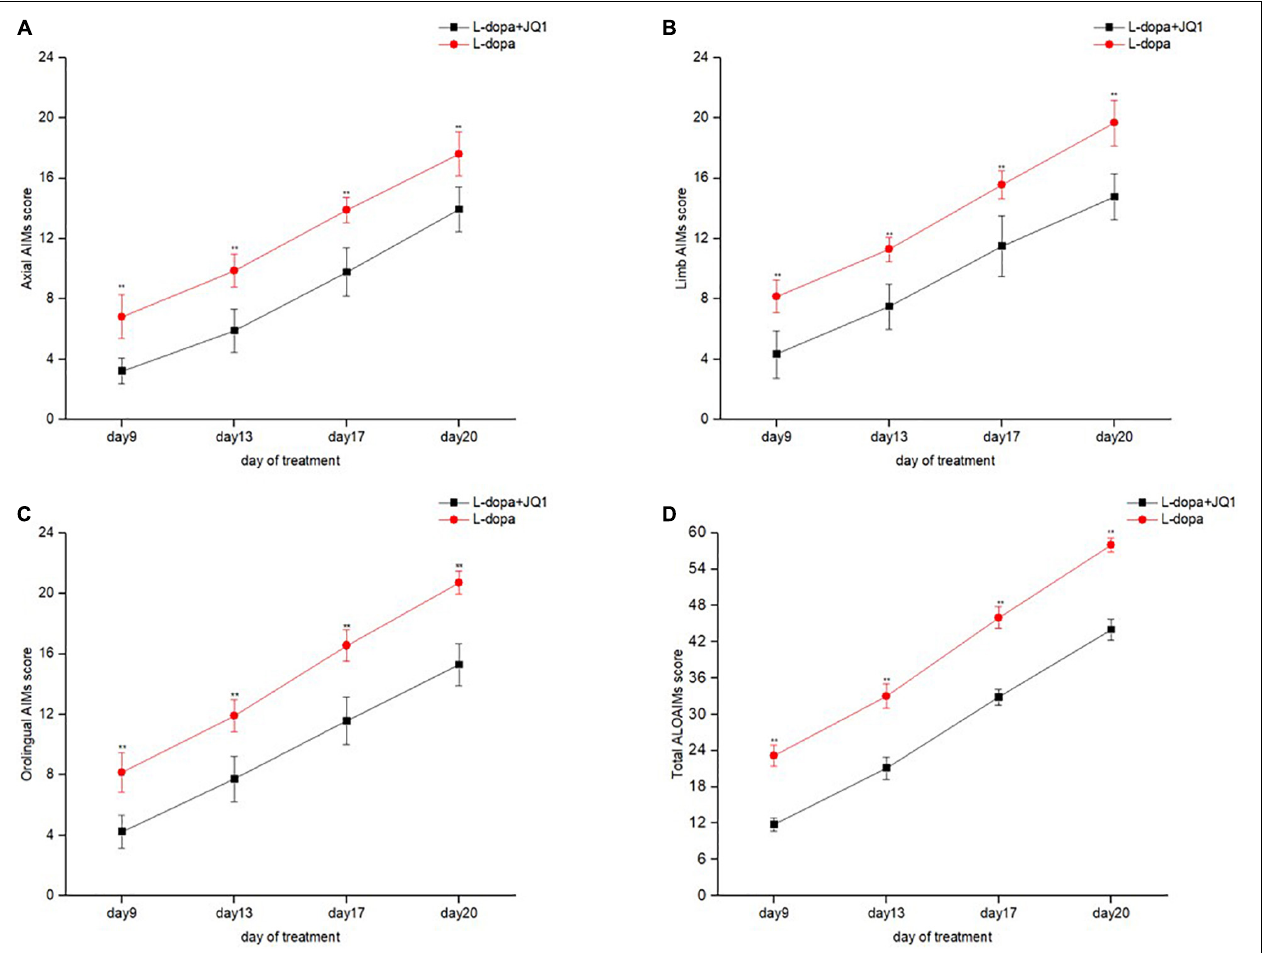
FIGURE 2 | Dyskinetic movement assessment of the 6-OHDA-lesioned PD rats during the treatment with L-dopa (L-dopa, 12 mg kg − 1 , bensarazide, 6 mg kg − 1 , i.p., once a day) (L-dopa group, n = 18) and L-dopa (L-dopa, 12 mg kg − 1 , bensarazide, 6 mg kg − 1 , i.p., once a day) plus JQ1 (25 mg kg − 1 , i.p., once a day) (L-dopa + JQ1 treatment group, n = 18). Measures of axial (A) , limb (B) , orolingual (C) , and the total ALO AIMs (D) in the rats treated with L-dopa and L-dopa + JQ1 on each assessment during the 21 days of treatment. During the period, the 6-OHDA-lesioned rats in the PD + L-dopa group showed a robust increase in the scores of the total ALO AIM assessment and each of the subitems, with apparent dyskinetic movements. By contrast, this phenomenon was apparently inhibited in 6-OHDA-lesioned PD rats treated with L-dopa plus JQ1 (L-dopa + JQ1 treatment group). The scores of total ALO AIM assessment and its subitems in the L-dopa treatment group were all significantly higher than in the L-dopa + JQ1 treatment group at each assessment ( p < 0.001). Data are presented as mean ± SD; ** p < 0.001 vs. PD + L-dopa